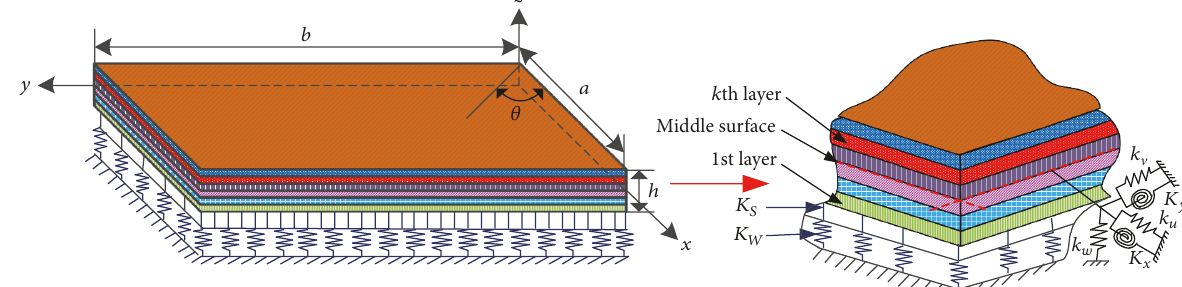
Figure 1: Rectangular plate resting on elastic